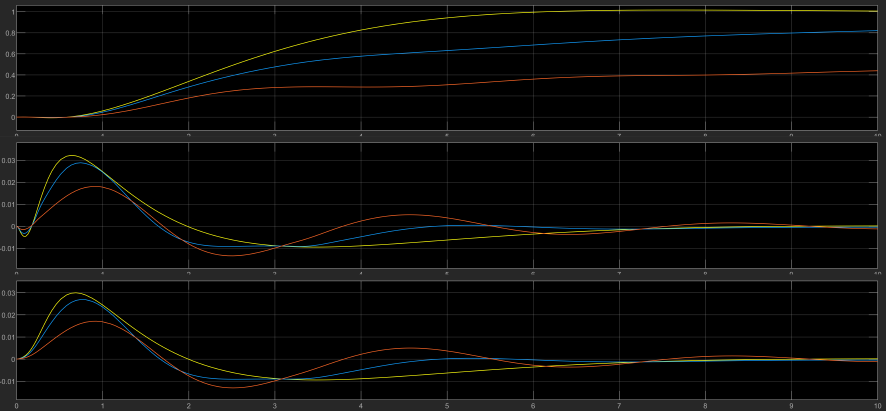
Figure 20. Comparison of FLC (light blue), LQR (yellow), and the modified FLC